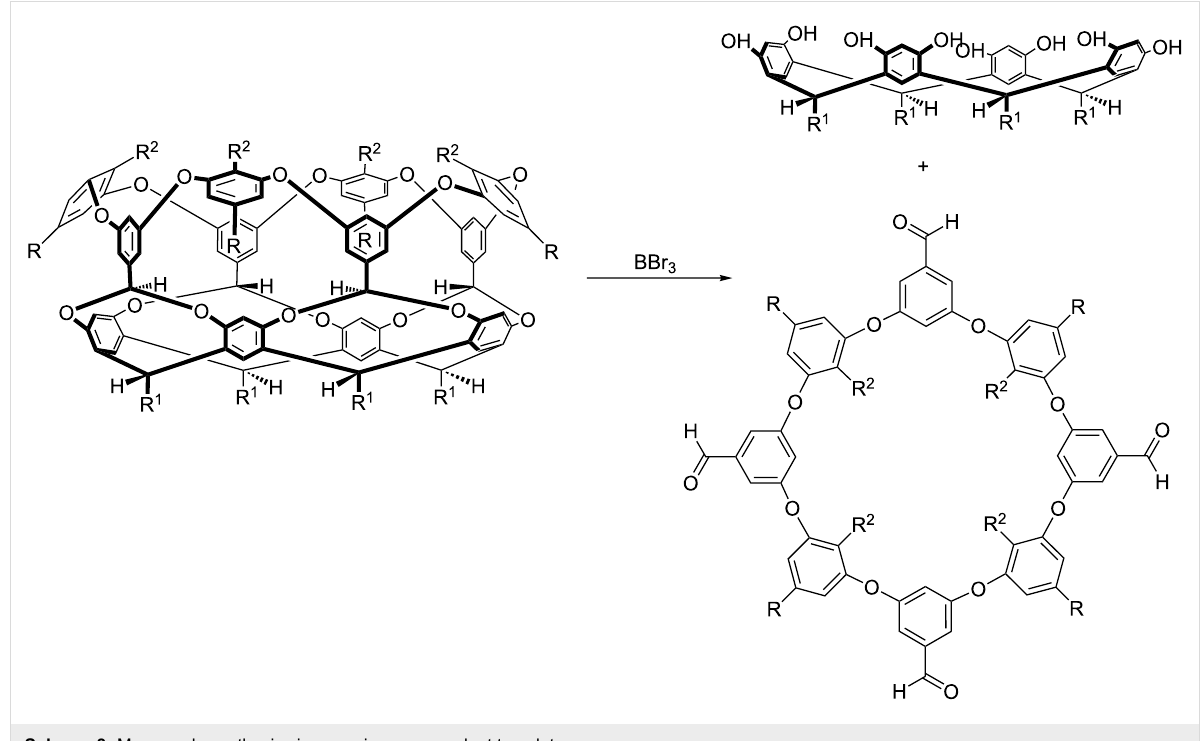
Scheme 8: Macrocycle synthesis via resorcinarene covalent templates.